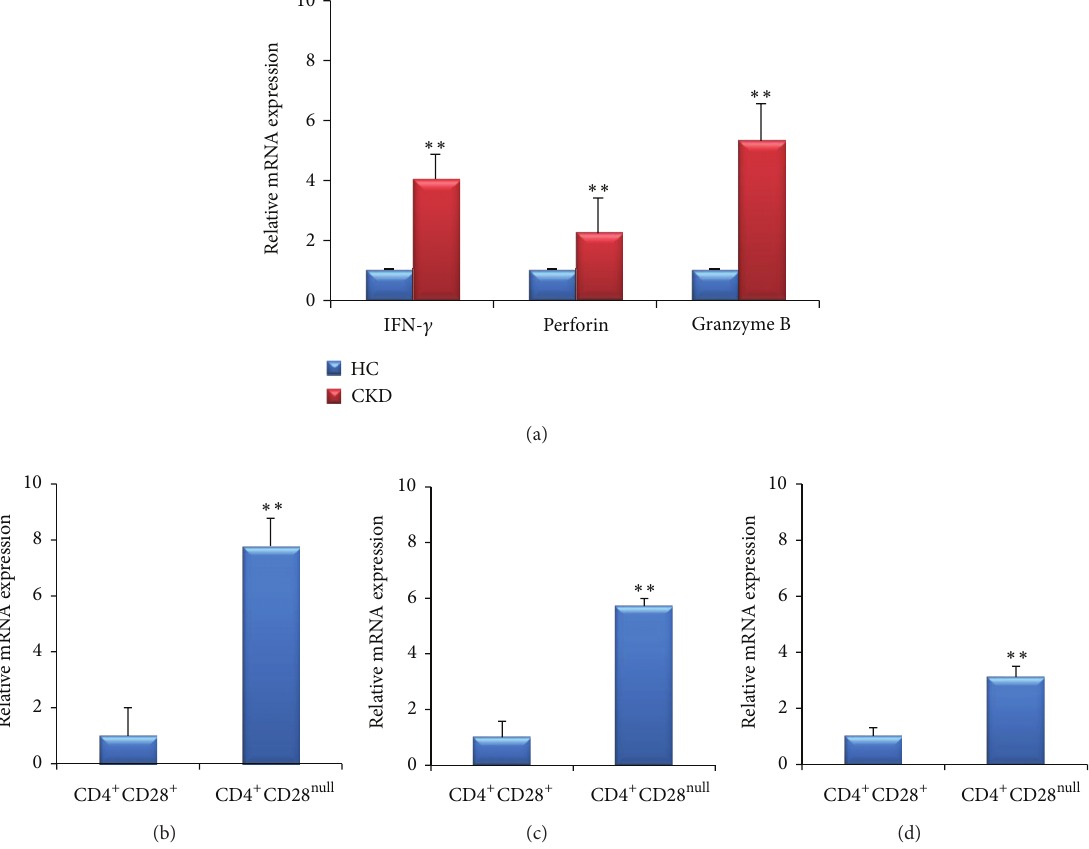
Figure 2: mRNA expression of (a) IFN- 𝛾 , perforin, and granzyme B in CD4 + CD2 8 null cells in CKD and HC; ((b)–(d)) IFN- 𝛾 , perforin, and granzyme B in CD4 + CD28 + and CD4 + CD2 8 null T-cells, respectively, in CKD subjects. ∗∗ 𝑃 < 0.0001